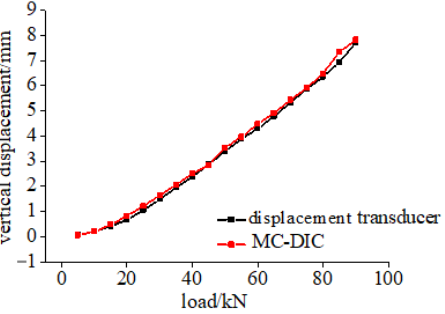
11 of 20 Figure 10. RMS error of strain computed from the static undeformed beam. Through adjusting DIC calculation parameters both in noise analysis and actual ex- periment analysis, the parameter selection can be confirmed considering the balance be- tween noise filtering and accuracy. The subset size is set to 35 × 35 pixels, the grid step size is set to 7 pixels, and the strain calculation window size is set to 15 × 15 calculation points. The full-surface speckle pattern and the 3D surface topography are presented in Figure 11. The figure indicates that the continuous-view MC-DIC system can completely restore the speckle image and 3D contour of the entire beam with large slenderness ratio. Figure 11. Full-surface speckle pattern and contour of the beam surface. Take the bottom mid-span point as an example, the displacement calculation result of MC-DIC is compared with the measurement data of displacement transducer. Clearly observed from Figure 12, the two curves are basically consistent, and the relative error is